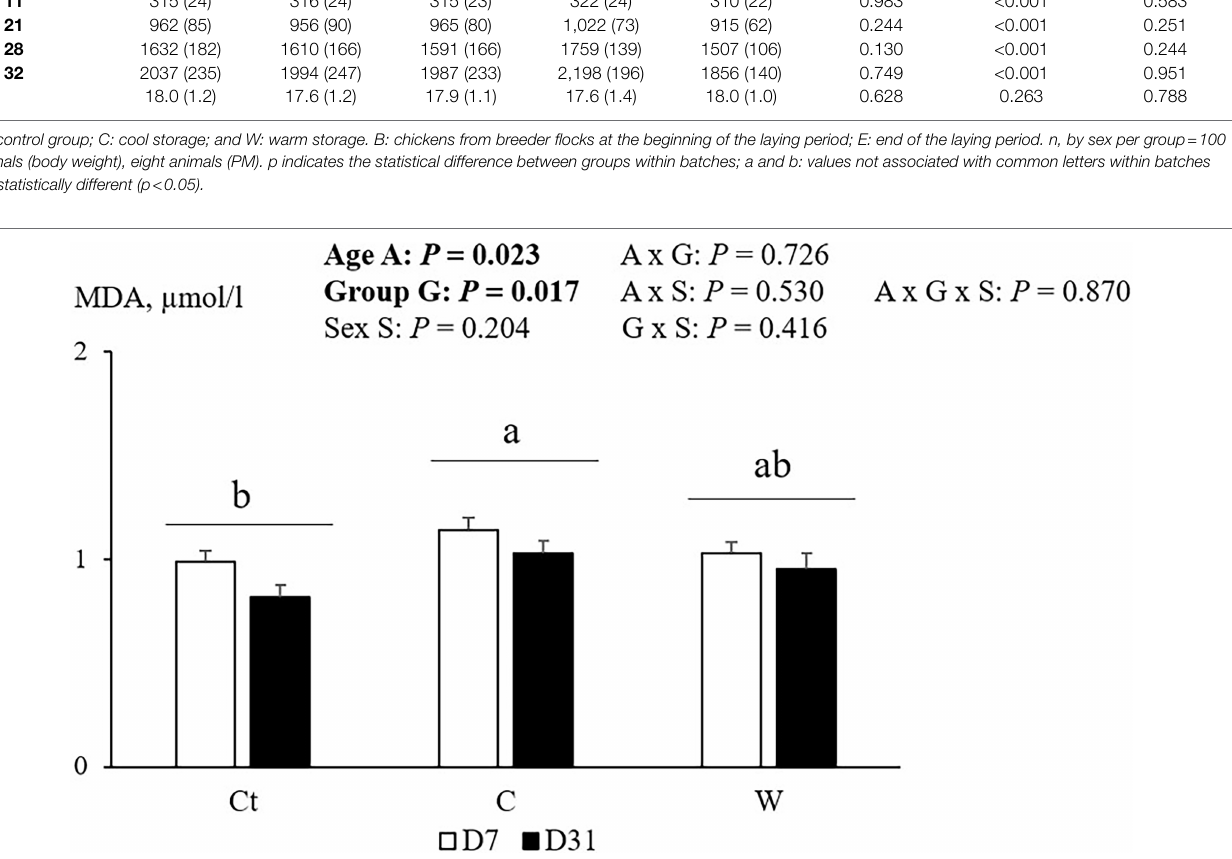
FIGURE 4 | TBARS plasma index [expressed as Malondialdehyde concentration (MDA)] for E chickens (from eggs of breeder flock at the end of the laying period) at 7 and 31 days, depending on egg storage conditions and age of broilers ( n = 8 animals, by sex per group). Ct: control group; C: cool storage; and W: warm storage. a, b: values not associated with common letters are statistically different ( p <